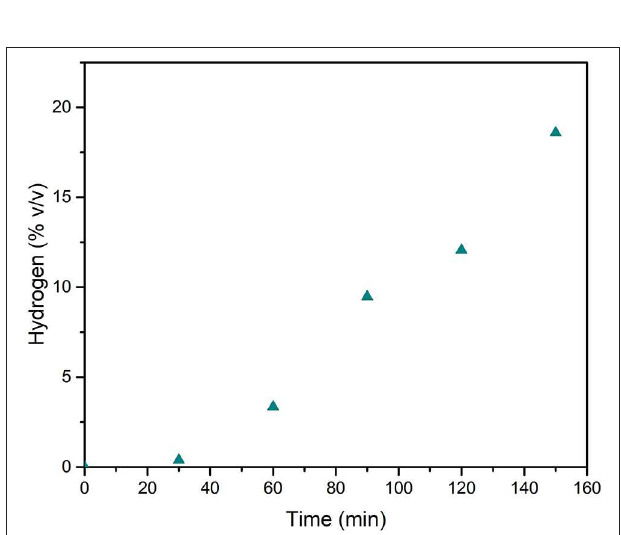
FIGURE 7 | Conversion data of CO 2 , plotted as a function of milling time, as observed during the series of mechanochemical tests performed with a pressure head of 1.5 bar of CO 2 .